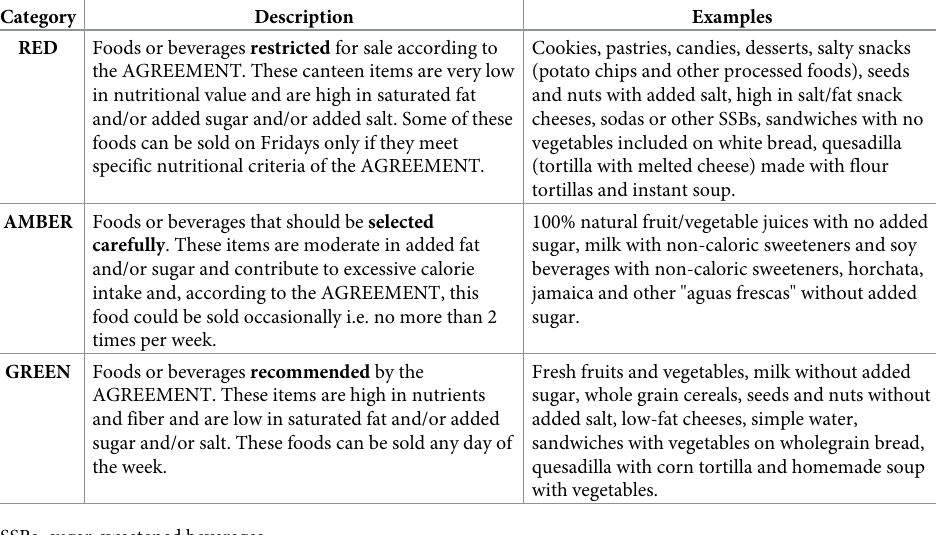
Table 1. Food classification for school canteens, using the traffic light system, according to the 2014 AGREEMENT. Category Description Examples